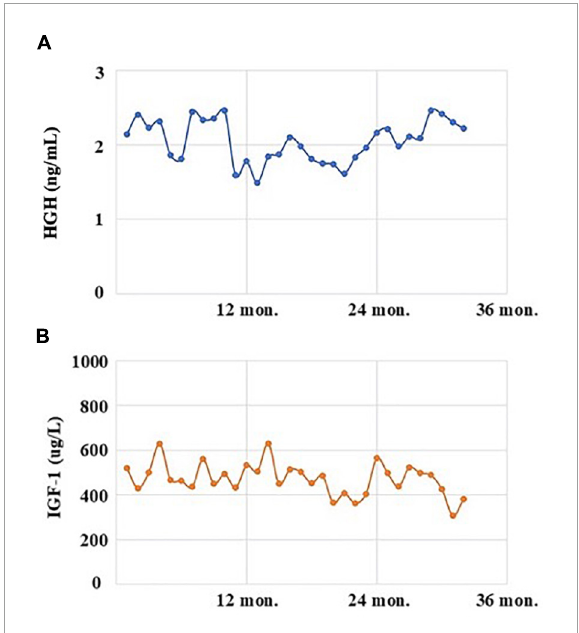
FIGURE1 The levels of human growth hormone (HGH, normal range: 0–2.47 ng/mL; A ) and insulin-like growth factor 1 (IGF-1, normal range: 94–284 µ g/L; B ) of the acromegalic patient with the treatment of Sandostatin LAR in recent 3 years.